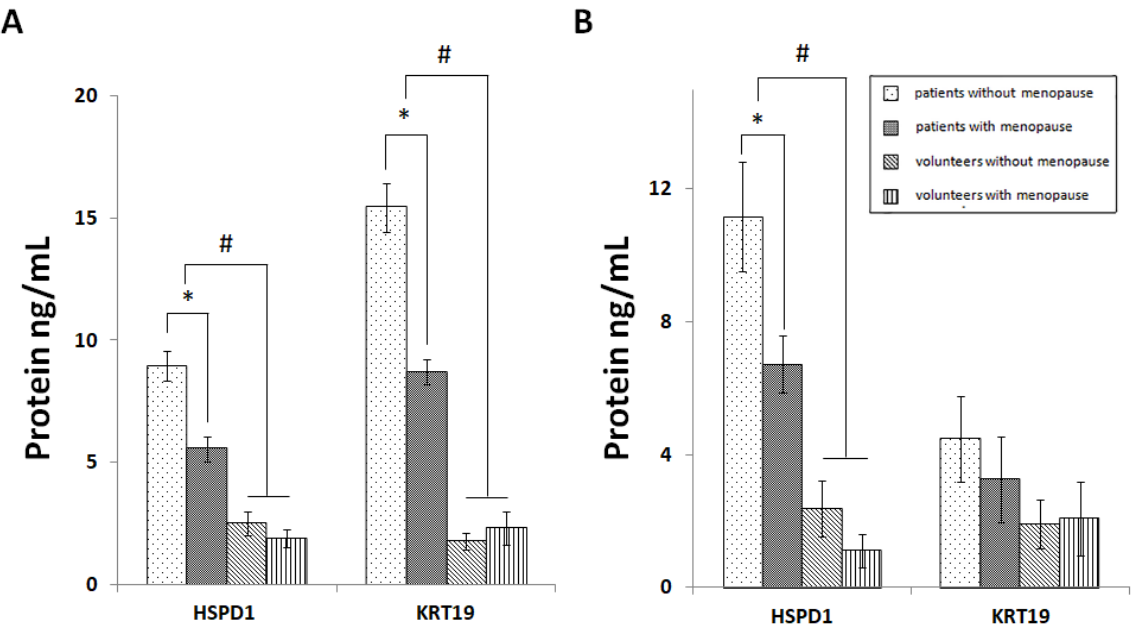
Figure 4. The levels of the expression of estrogen-responsive proteins in clinical samples of psoriasis patients and healthy volunteers, assessed by ELISA. ( A ). The levels of gene expression in the samples of patients’ lesional skin and in the skin of healthy volunteers. ( B ). The levels of gene expression in the PBMC obtained from the patients’ blood and from the blood of healthy volunteers. The following individuals participated in these experiments: psoriasis patients without menopause (n = 10); psoriasis patients with menopause (n = 10); healthy volunteers without menopause (n = 6); and healthy volunteers with menopause (n = 5). * p < 0.05 when women without menopause compared to women with menopause. # p < 0.05 when patients compared to healthy volunteers. Protein concentrations were measured in ng/mL.